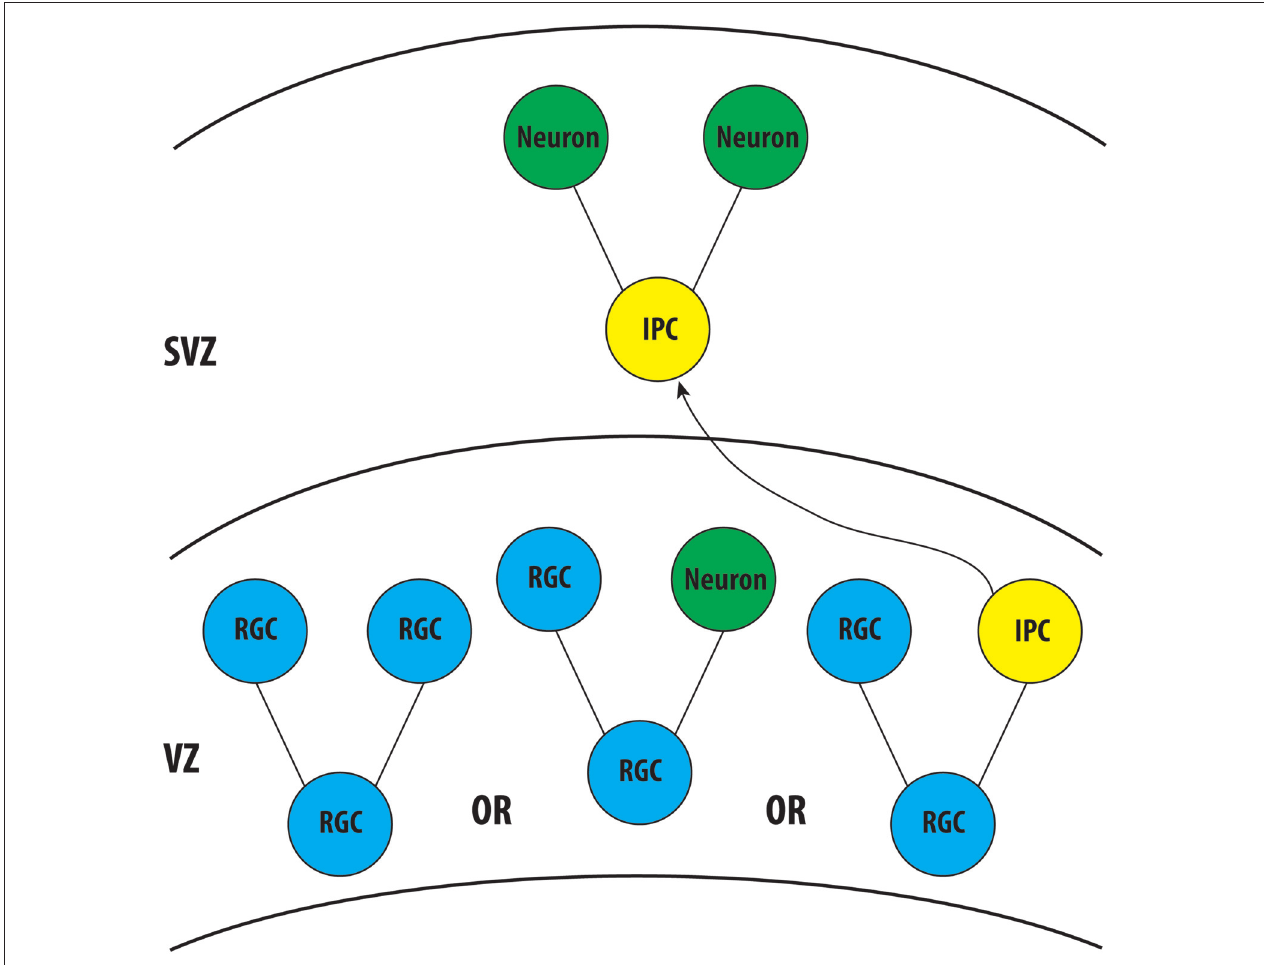
FIGURE 2 | Illustration demonstrating the role of radial glial cells and intermediate progenitor cells (IPCs) in neurogenesis during cortical development. Three isoforms, 14-3-3 ε , ζ and γ , are known to be expressed in these cells during cortical development. Further analysis is required for the remaining isoforms. VZ, Ventricular Zone; SVZ, Subventricular